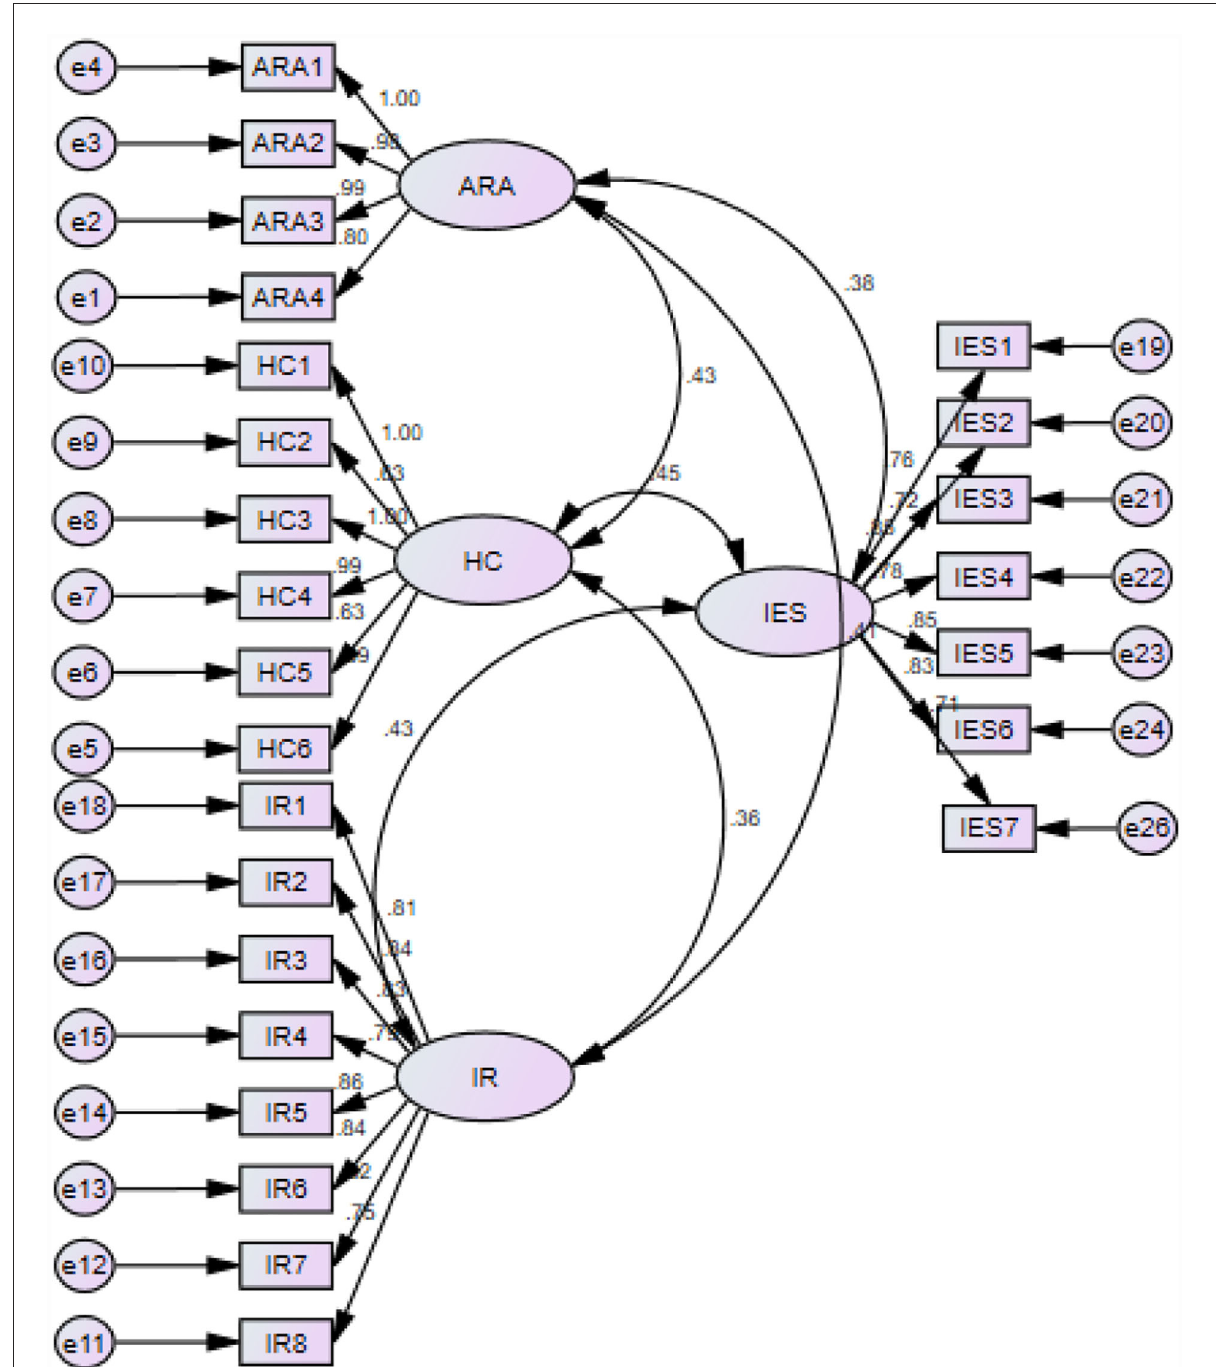
FIGURE3 Measurement model